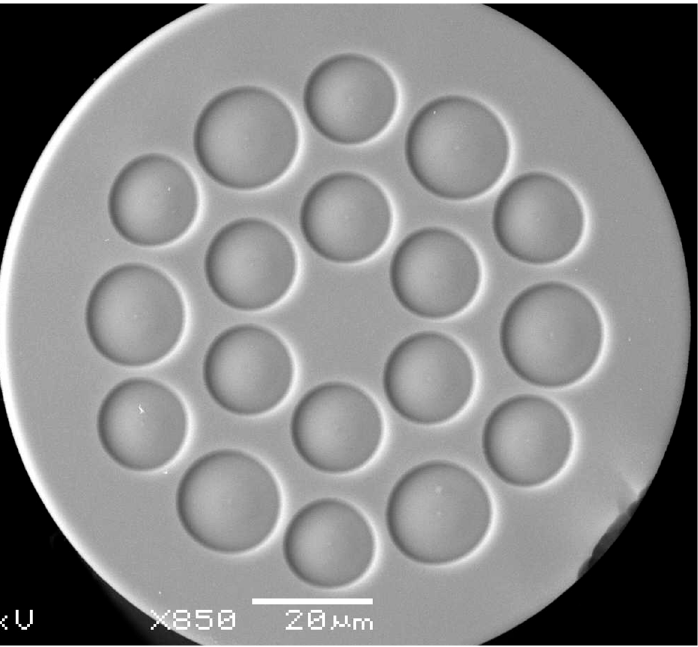
Figure 14. SEM image of the cross-section of the fabricated MOF-18; D fi ber = 135 µm; D core = 22.5